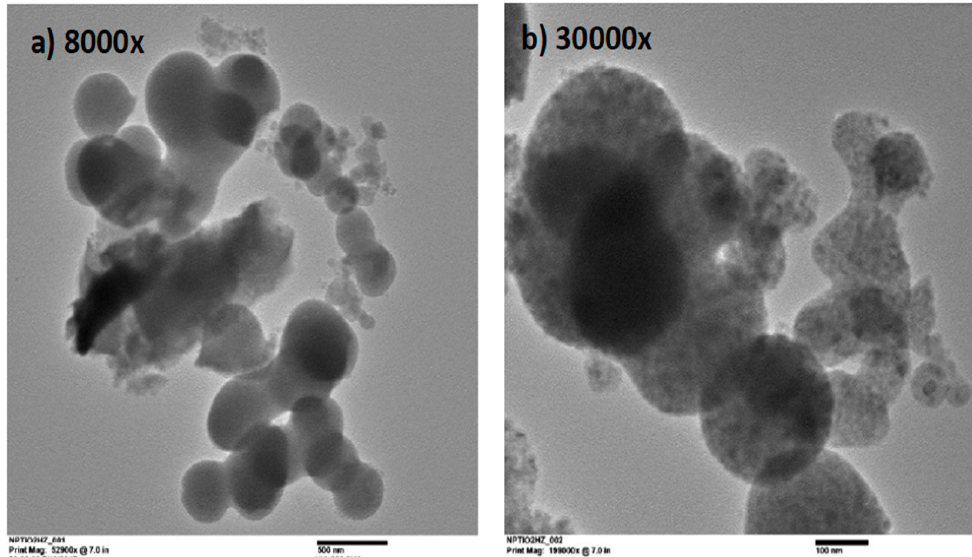
Figure 9. TEM images for a TiO 2 sample with 24% anatase and amplified by ( a ) 8000 × and ( b ) 30,000 × .